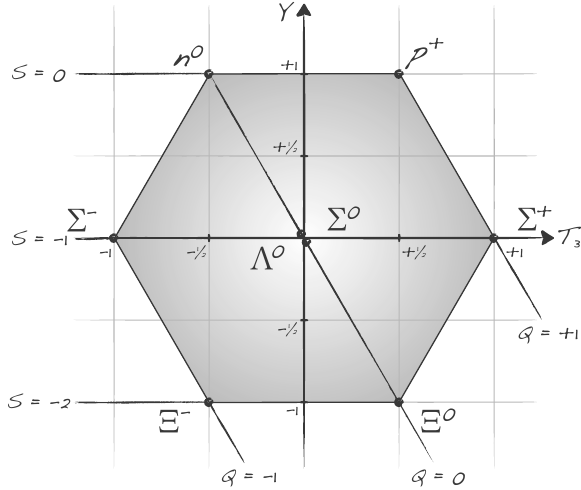
Figure 2. The baryon